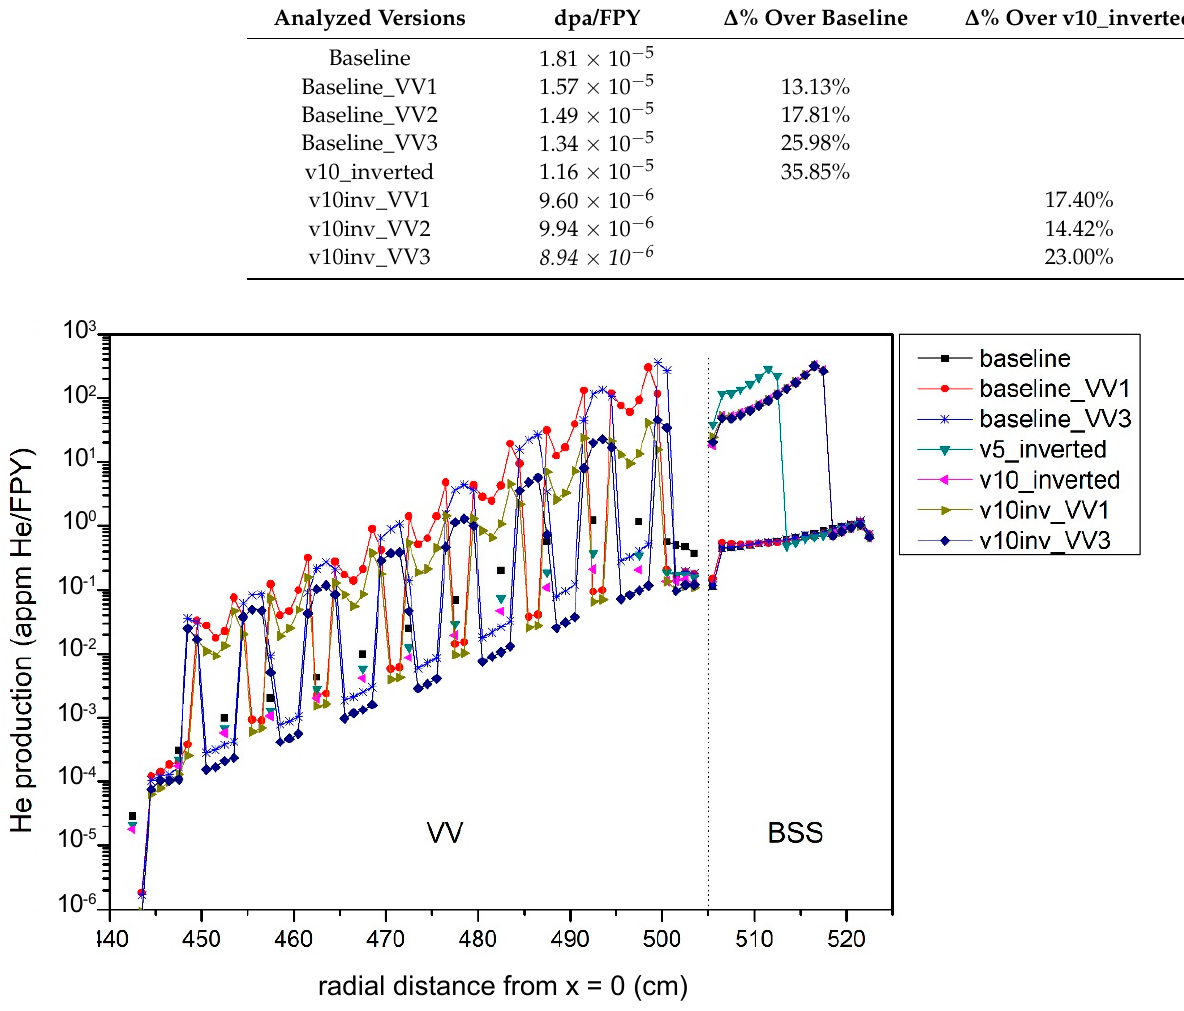
Figure 11. Helium production (appm He/FPY) as radial profile from the BSS to the TFC for the 3 VV new configurations applied to the baseline and v10_inverted versions in comparison to the standard baseline, v5_inverted and v10_inverted versions.